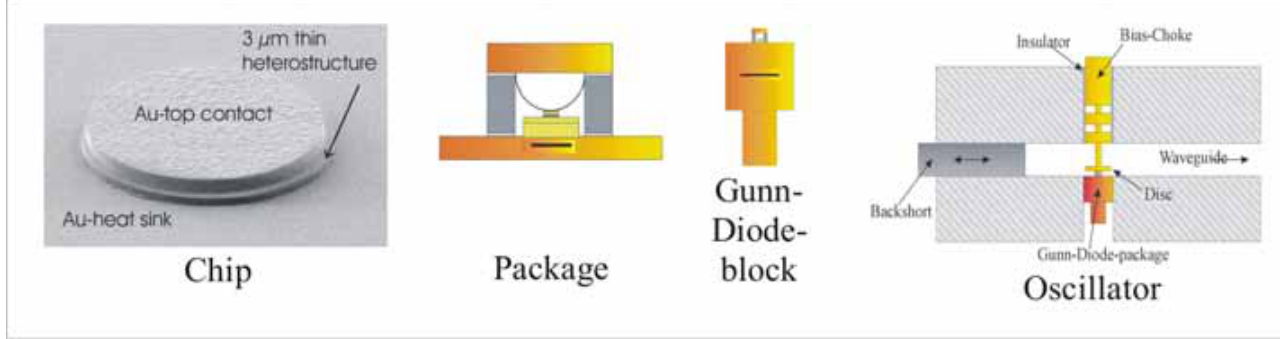
Figure 5. Sketch of the packaging and mounting to the oscillator: chip (cid:198) package (cid:198) Gunn-diode block (cid:198)